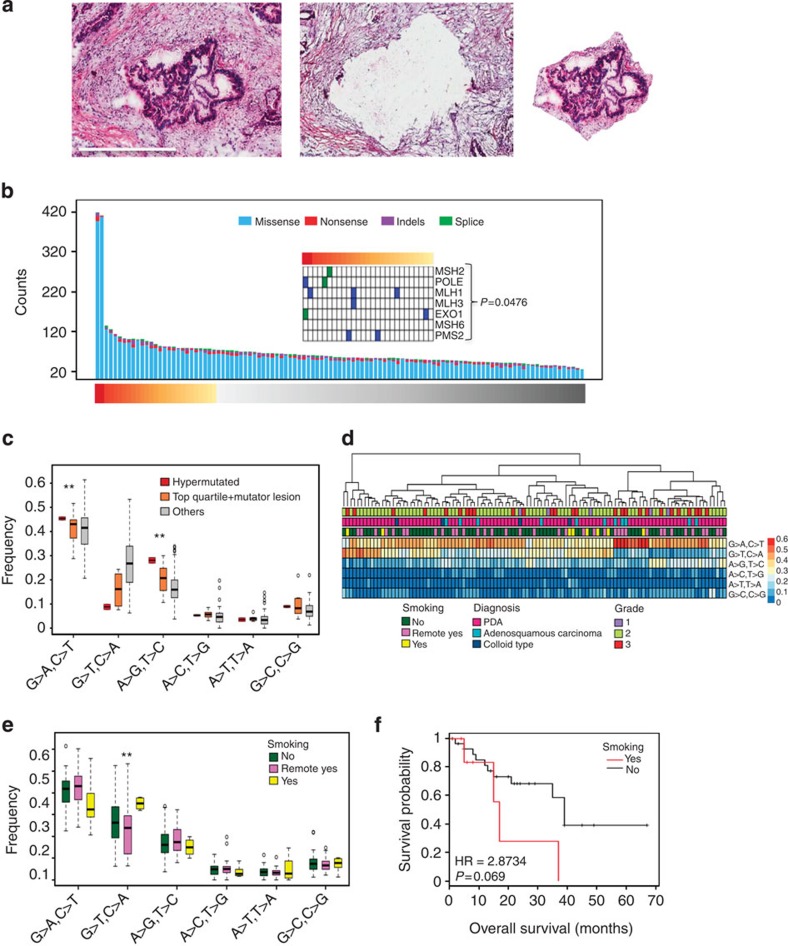
Overall mutational landscape of PDA and association with etiological features of disease.(a) Representative image of the needle dissection approach used to enrich tumour cells for whole-exome sequencing (scale bar, 600 μM) (b) Mutational burden across the sequenced cohort. The presence of genetic alterations in genes associated with mutator phenotypes are shown for the cases with the top 25% of mutational burden. Association with mutational burden was determined by a hypergeometric test. (c) Mutation spectra of the hypermutated cases, top quartile cases with mutator mutations and others (** denotes P<0.05, Student's t-test). The boxes show the distance between the first and third quartile with the whiskers extending up to 1.5 times the interquartile range. (d) Unsupervised hierarchical clustering of cases based on mutation spectra. (e) Mutation spectra based on smoking status, the increase in G>T transversion is significant (P<0.05, Student's t-test). The boxes show the distance between the first and third quartile with the whiskers extending up to 1.5 times the interquartile range. The unfilled circles represent possible outliers. (f) Association of PDA smoking status with overall survival. Hazard ratio and P value were obtained from Cox proportional hazard test.